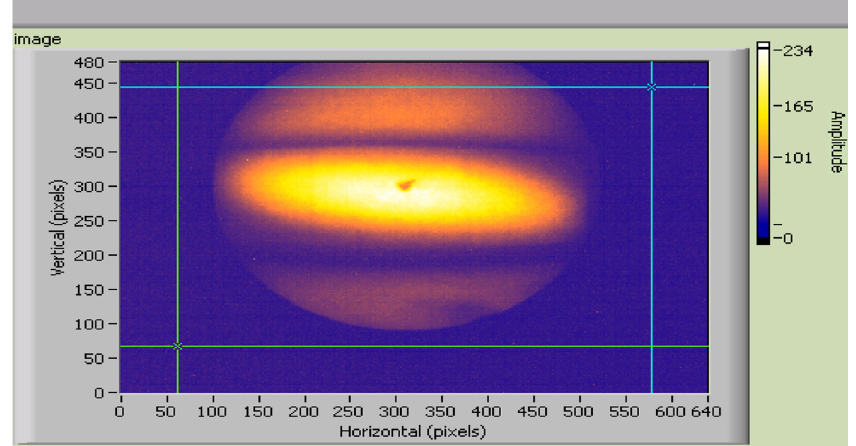
FIG. 2. (Color) Beam image from the target view screen [4], where the beam size is about 20 cm by 7 cm.